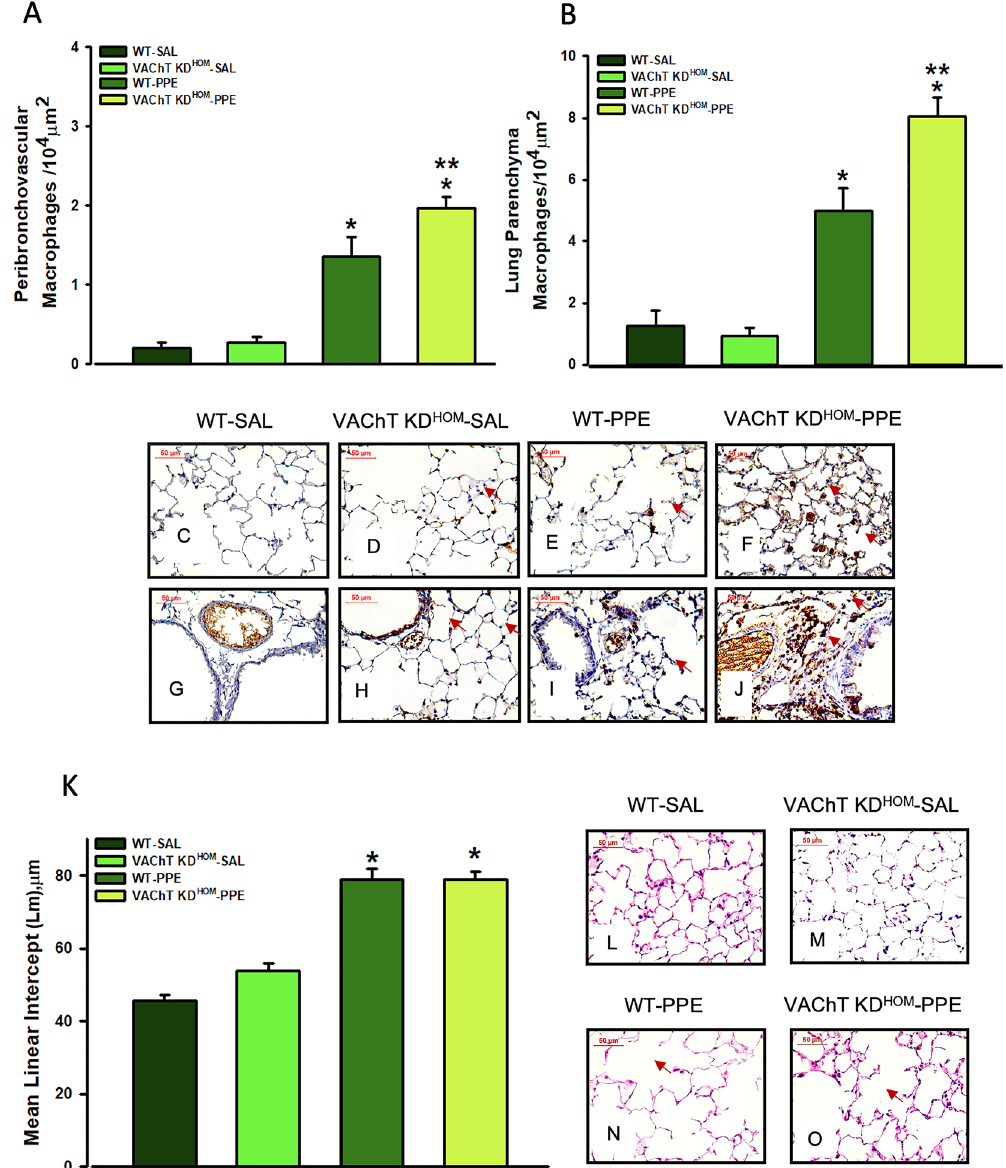
Figure 2. Macrophage MAC-positive cells and alveolar destruction (mean linear intercept, Lm). Data represent the mean ± S.E.M of six to seven animals per group. Macrophage MAC-positive cells in peribronchovascular ( A ) and lung parenchyma ( B ) and representative photomicrography from lung parenchyma and peribronchovascular area showing positive cells in animal lung from WT-SAL ( C and G ), VAChT KD HOM- SAL ( D and H ), WT-PPE ( E and I ) and VAChT KD HOM- PPE ( F and J , arrows) groups. Data from alveolar destruction ( K ) and representative photomicrography ( L – O , WT-SAL, VAChT KD HOM- SAL, WT- PPE and VAChT KD HOM- PPE, respectively. Arrows shows the alveolar destruction. *P < 0.001 compared to WT-SAL and VAChT KD HOM -SAL; **P < 0.05 compared to WT-PPE; # P < 0.05 compared to VAChT KD HOM